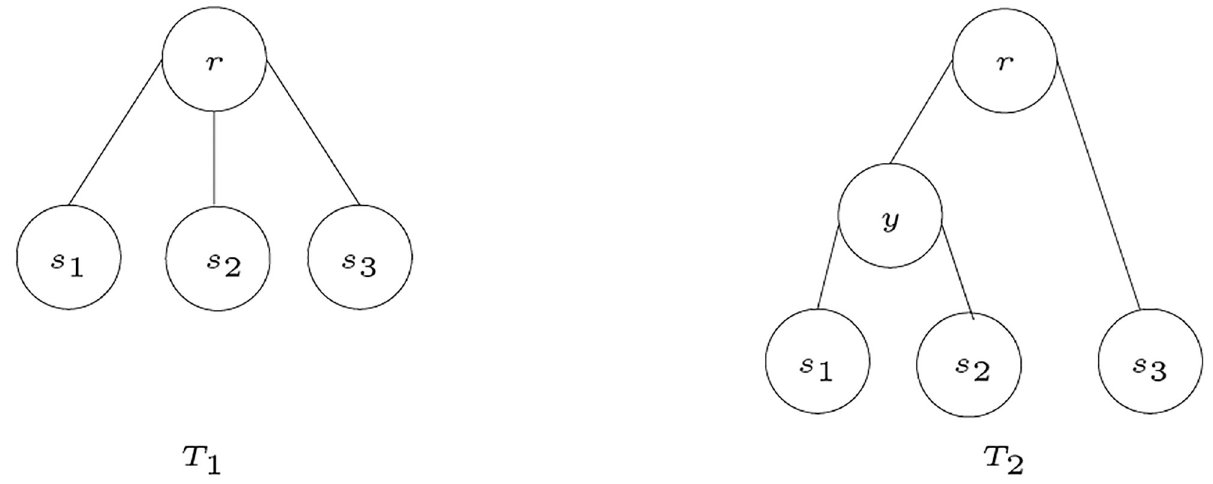
Fig 4. Refinement of T 1 to T 2